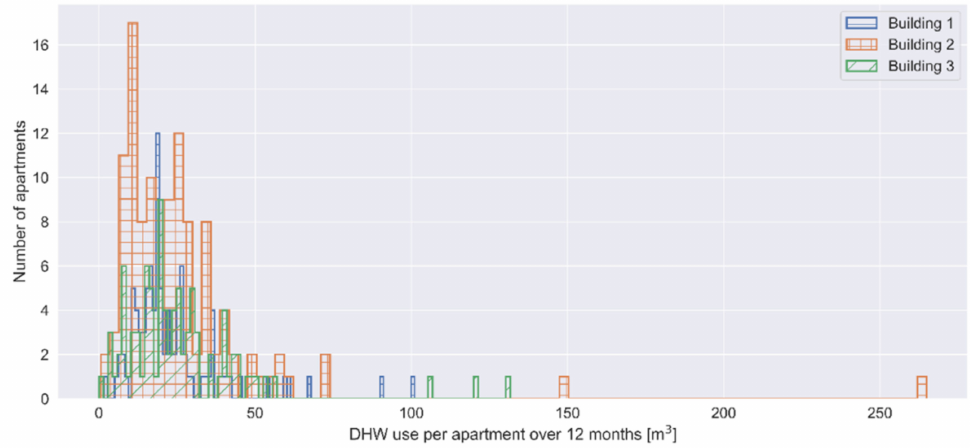
Figure 34. Electricity consumption in the apartments. Overall electricity consumption metered in each apartment is grouped per building.